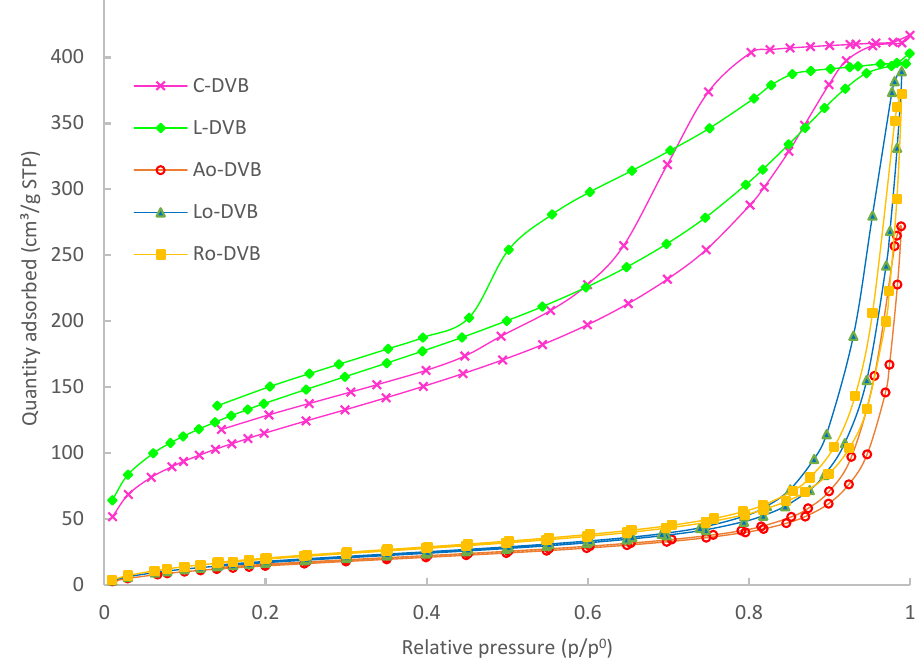
Figure 4. The nitrogen adsorption-desorption isotherms of the studied polymers.